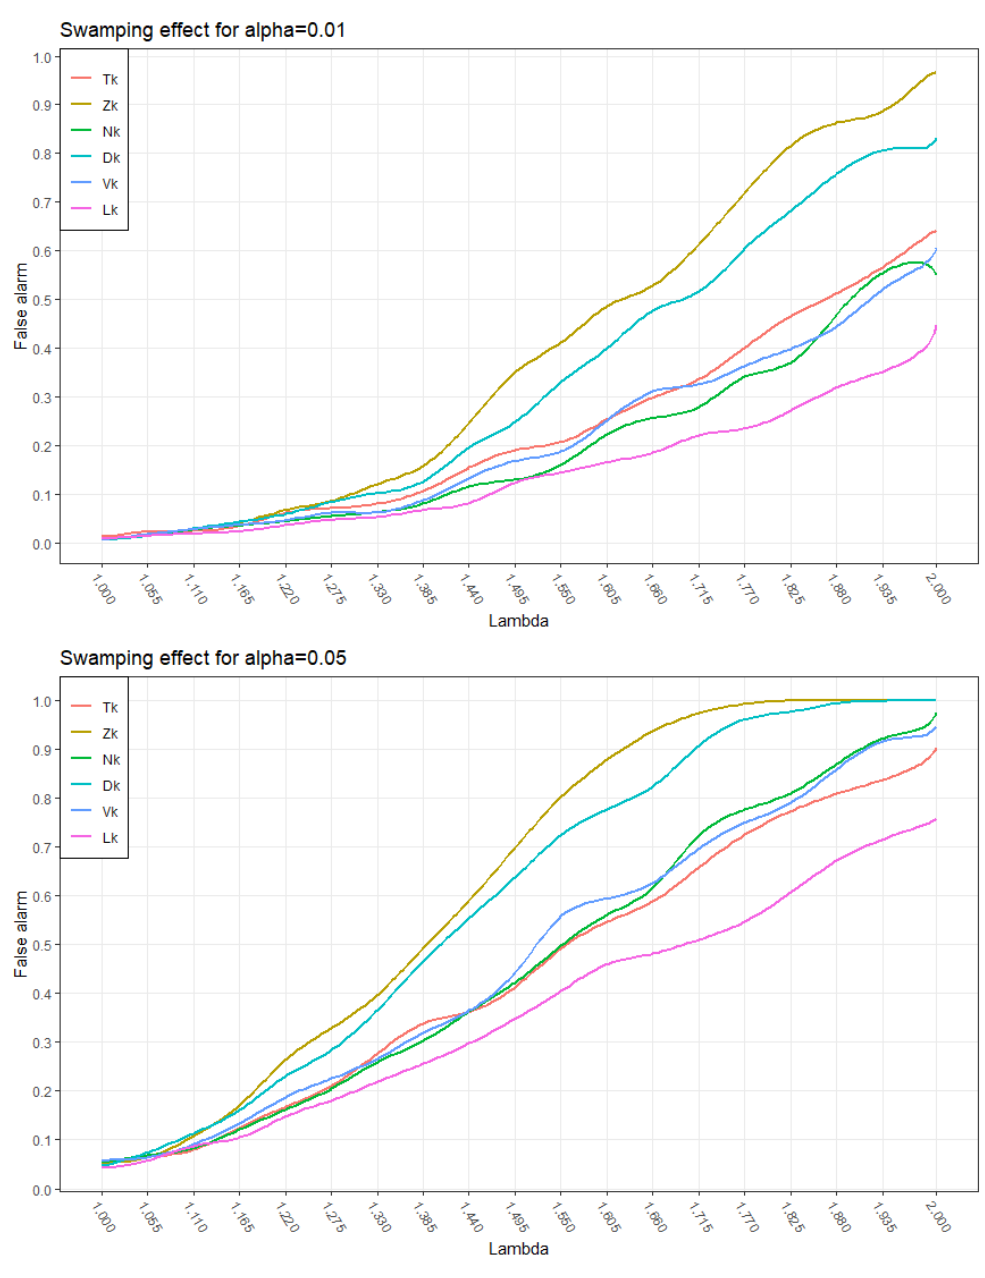
Figure 3. False alarm of statistics for m = 5, k = 2, k o = 1, and n =